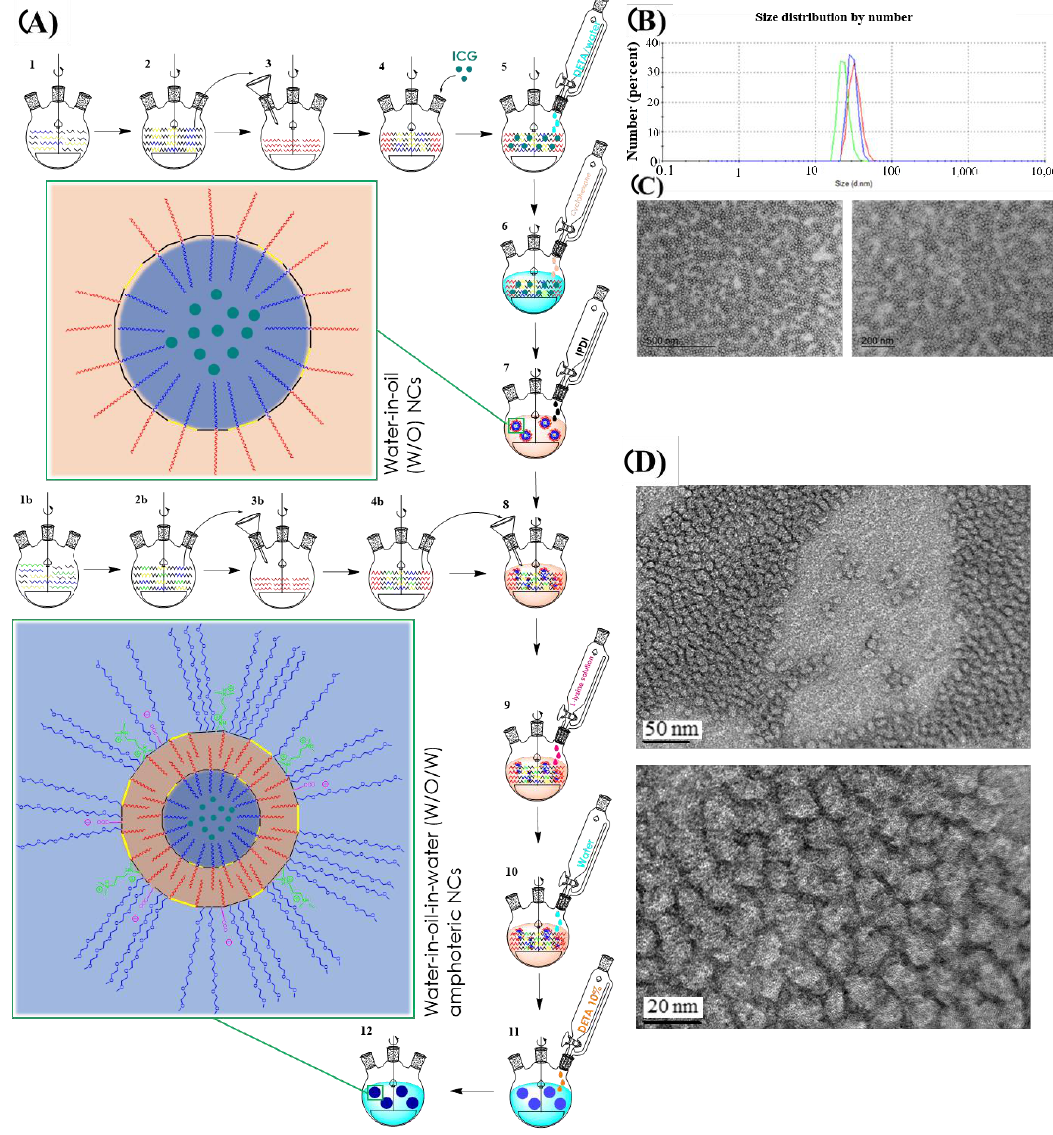
Figure 2. ( A ) Schematic synthesis of ICG-loaded amphoteric double-walled polyurethane nanocap- sules. Steps 1 to 4 and 1b to 4b refer to the synthesis of both reactive polymers. Steps from 5 – 7